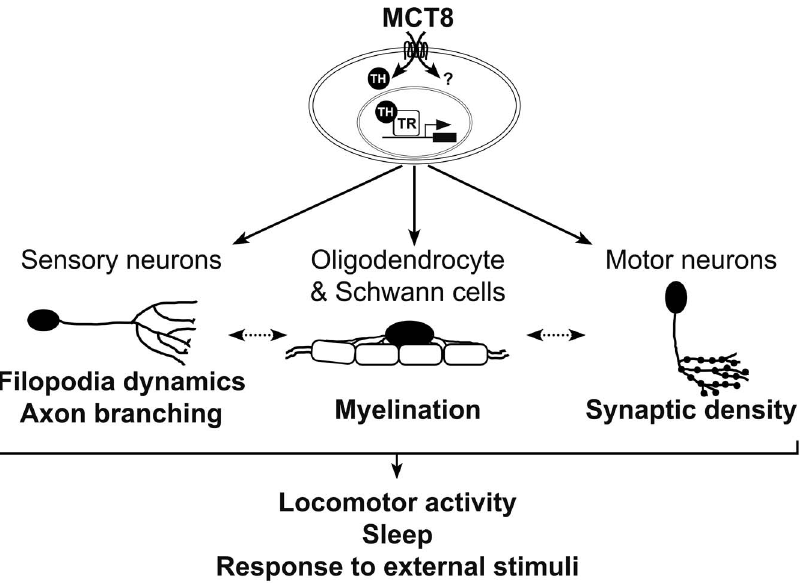
Figure 9. A proposed model for the mechanism underlying MCT8 deficiency. In zebrafish, MCT8 transports TH across the membrane of oligodendrocytes, Schwann cells, and neurons, and regulates gene expression through TRs. Other MCT8-dependent pathways can affect neuronal development, primarily at early embryonic developmental stages (represented by question mark). Loss of MCT8 affects myelination, filopodia dynamics, axon branching, and synaptic density. The deficiencies in axon processes and synapse numbers impaired the number of mature myelinated axons, or alternatively, deficiency in the development of glial cells alters filopodia dynamics, axon branching, and synaptic density (dotted arrow). The combined neural deficiencies alter behavioral performance, including locomotor activity, sleep and response to external stimuli. A portion of these MCT8-dependent deficiencies including the expression of myelin-related gene and axon outgrowth can be recovered by TH analogs. Similar mechanism may be applied in AHDS